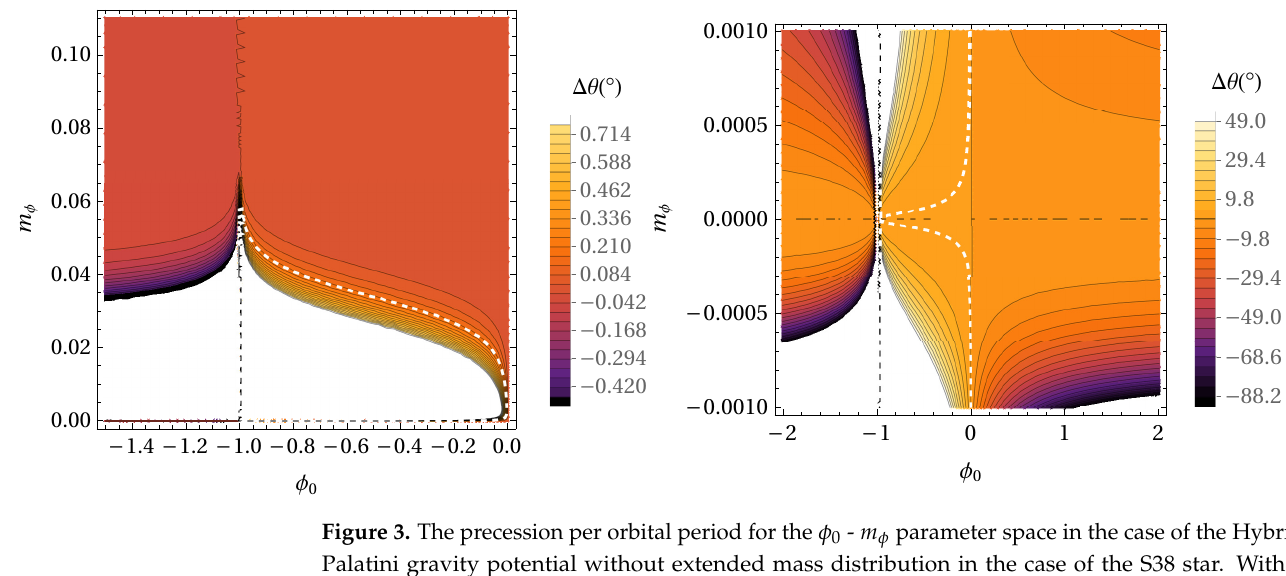
Figure 3. The precession per orbital period for the φ 0 - m φ parameter space in the case of the Hybrid Palatini gravity potential without extended mass distribution in the case of the S38 star. With a decreasing value of the precession angle, the colors are darker. Parameter m φ is expressed in AU − 1 . The white dashed line depicts the locations in the parameter space where the precession angle has the same value as in GR (0 ◦ .11). The right panel represents the same as the left panel but for smaller values of the m φ parameter.